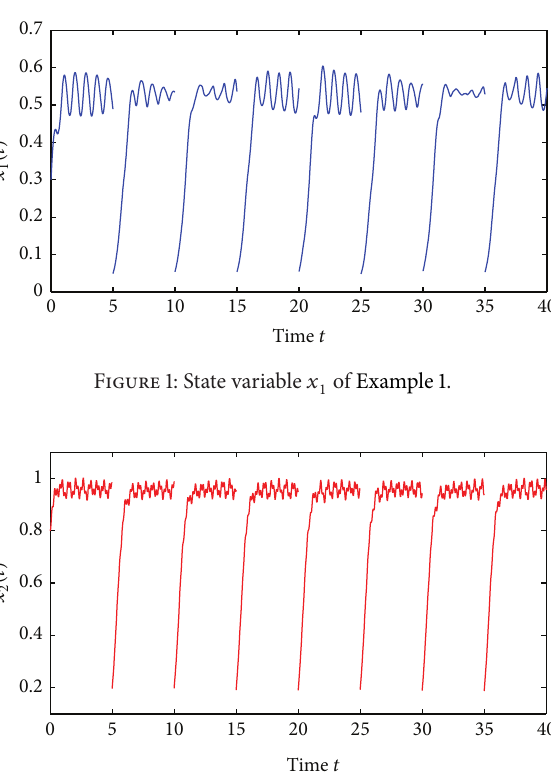
Figure 6: Stability of state variable 𝑥 3 of Example